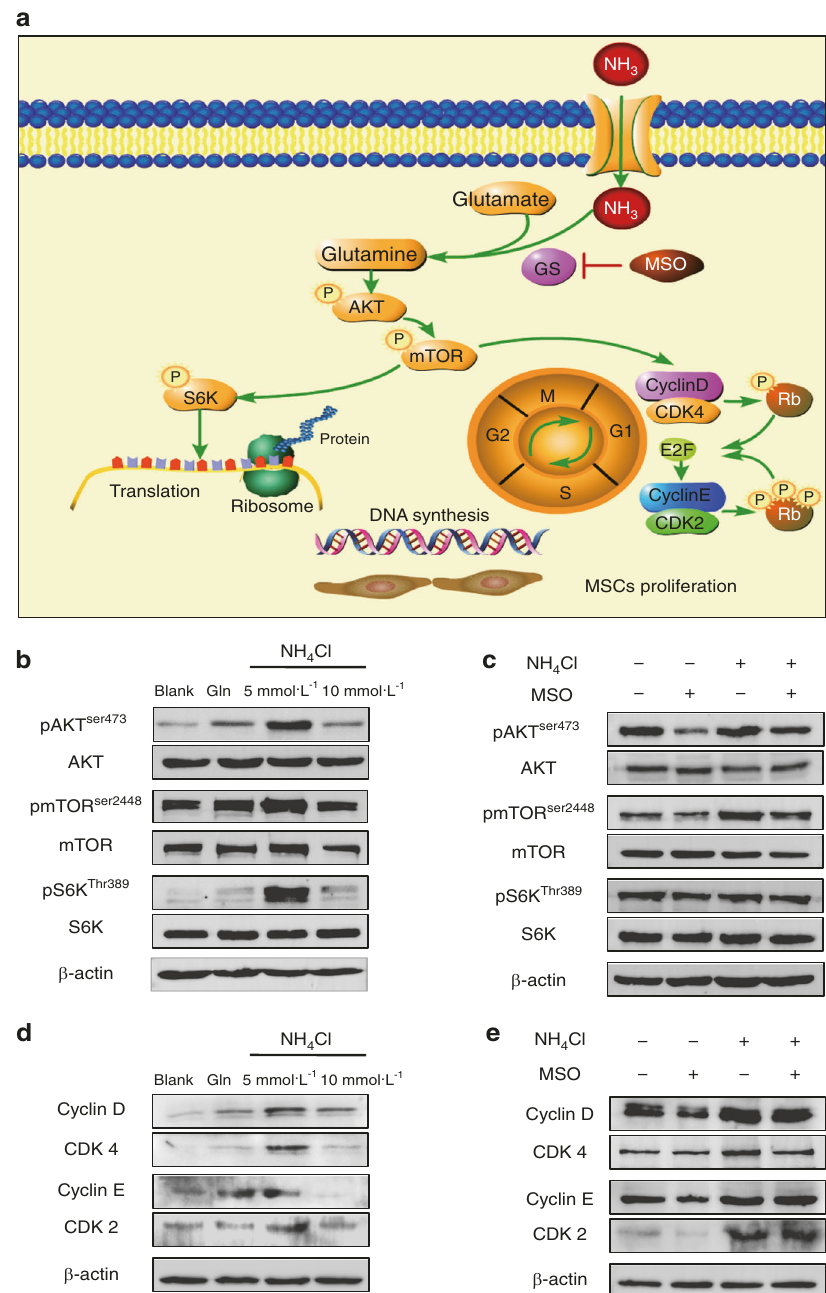
Fig. 6 mTOR activation and cell cycle regulation are involved in ammonia-induced mesenchymal stem cell proliferation. a Schematic of the metabolic pathway of ammonia in GS-expressing MSCs. b Western blot analysis of the AKT/mTOR/S6K pathway with or without NH 4 Cl or glutamine treatment. c Western blot analysis of the AKT/mTOR/S6K pathway with or without both NH 4 Cl treatment or MSO treatment. d Western blot analyses of cyclin D/CDK4 and cyclin E/CDK2 with or without NH 4 Cl or glutamine treatment. e Western blot analysis of cyclin D/CDK4 and cyclin E/CDK2 with or without both NH 4 Cl treatment or MSO